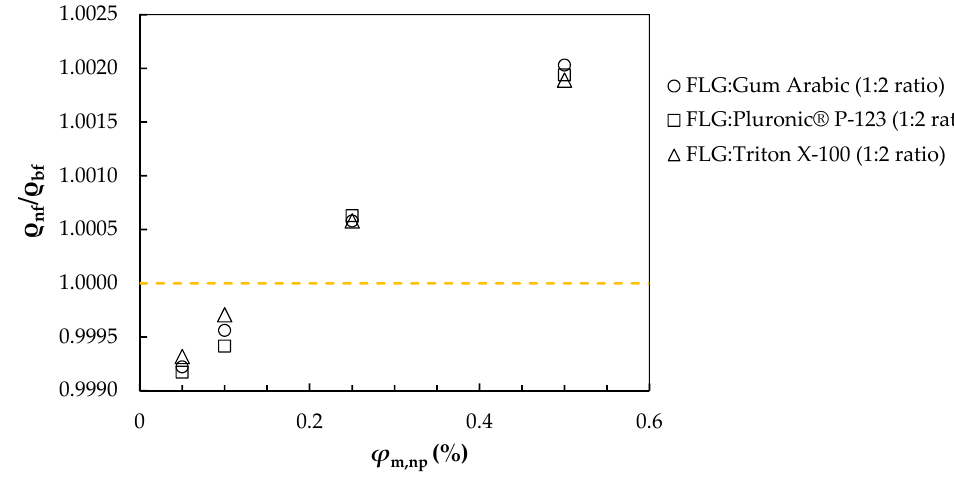
Table 3. Fitting parameters a i and standard deviations (St. Dev.) from Equation (1) for the base fluids and nanofluids with Triton X-100, Pluronic ® P-123, and Gum Arabic as surfactant for different mass fractions. Tyfoc